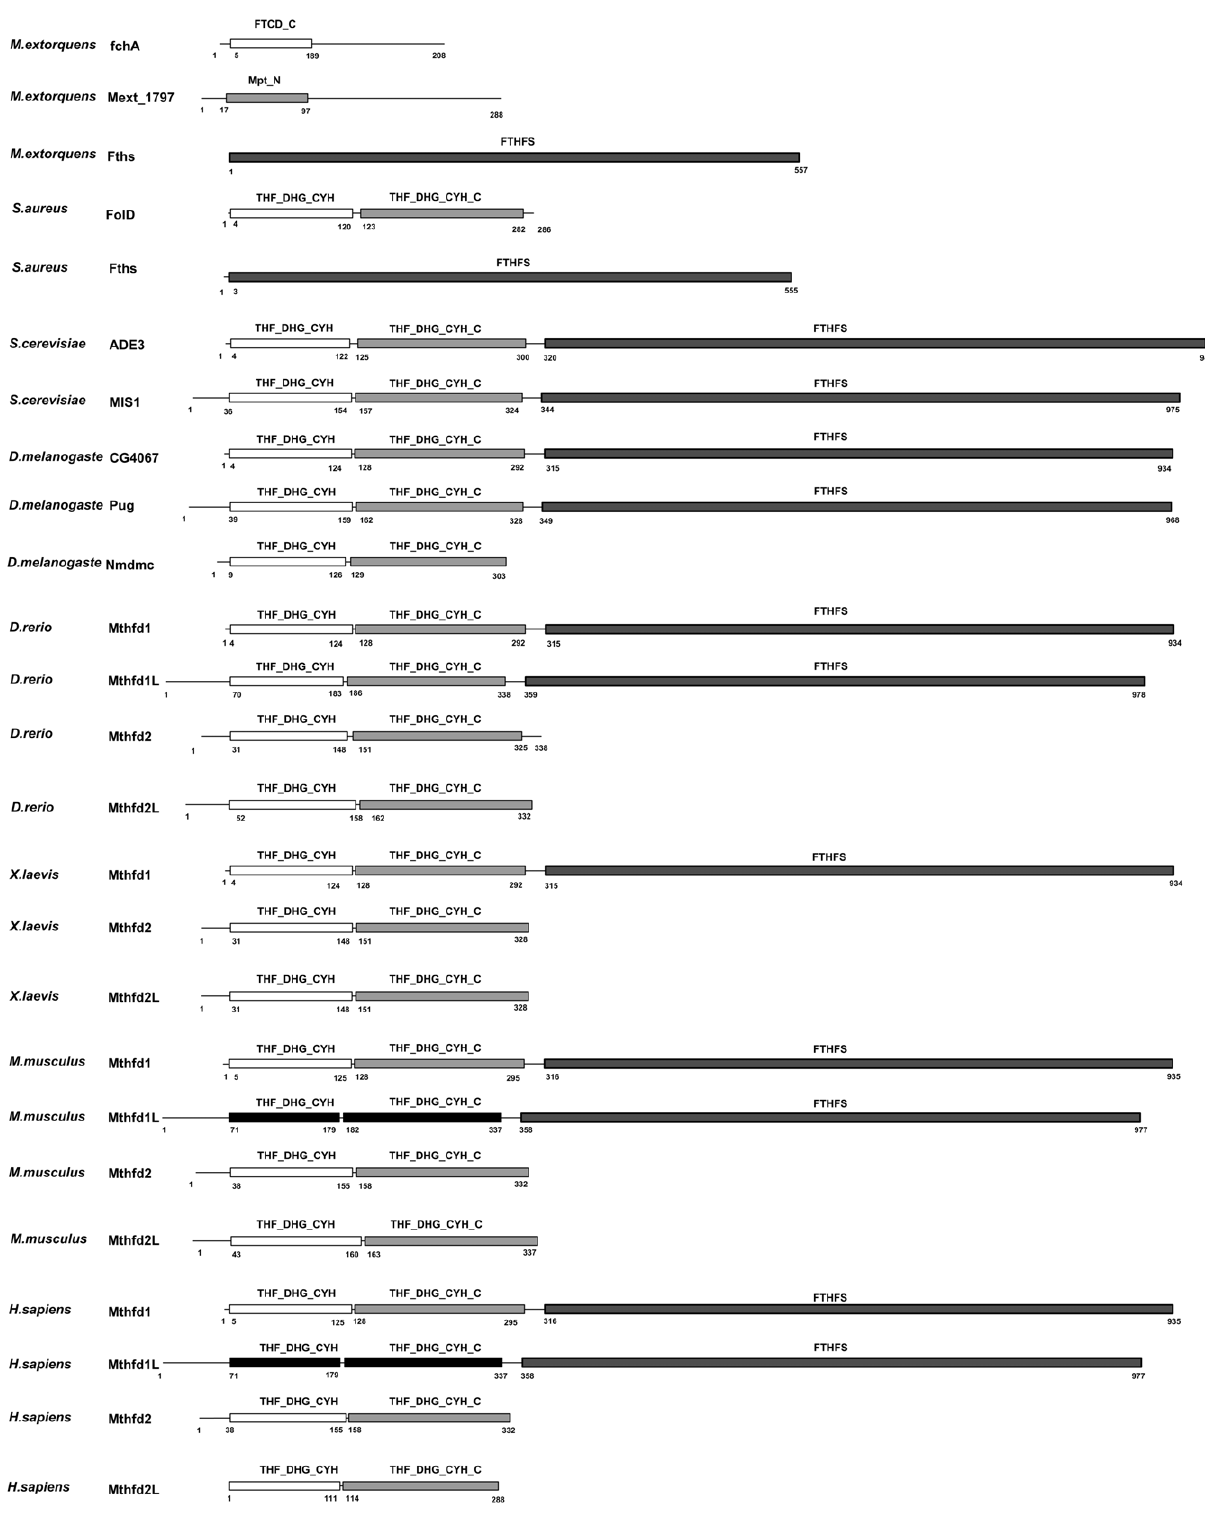
PLoS ONE | www.plosone.org